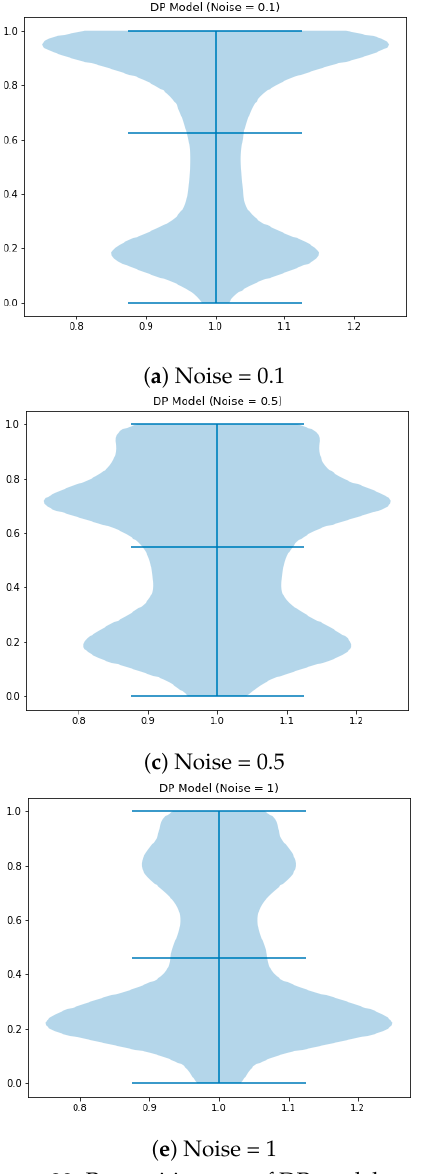
Figure 29. Recognition rate of DP